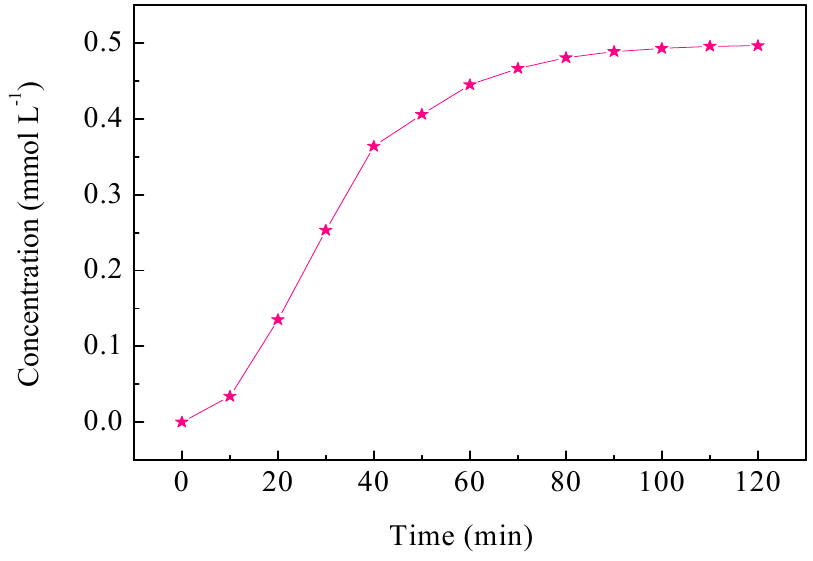
Figure 9. The variation of concentration of chlorine with time in the ECH of 3-CP.